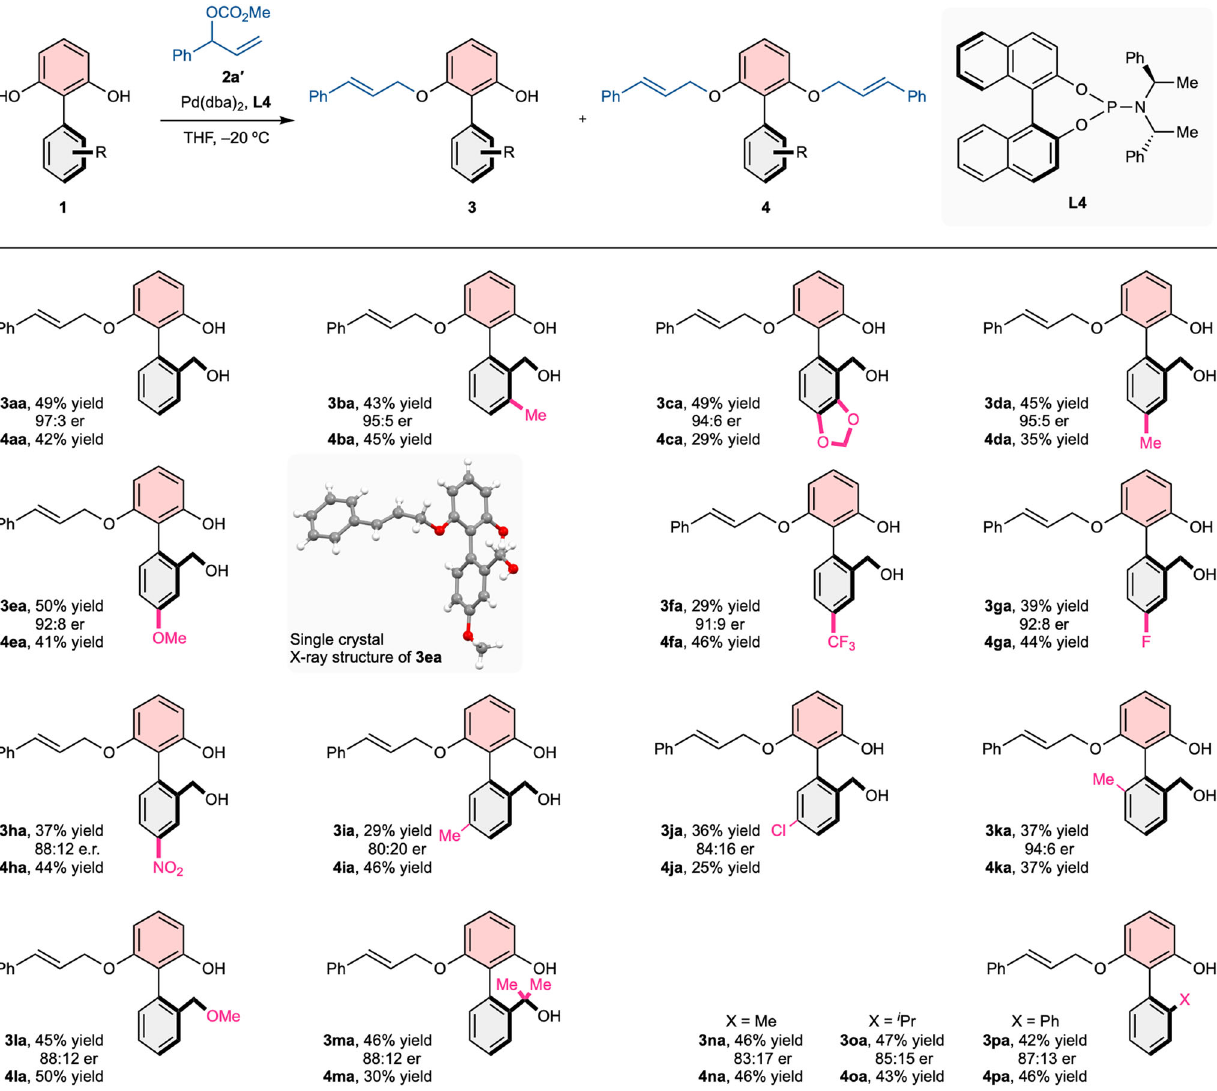
Fig. 2 Substrate scope of bottom aromatic ring. Unless otherwise noted, the reactions were carried out with 1 (0.10mmol, 1.0 equiv), 2a ′ (0.15 mmol, 1.5 equiv), Pd(dba) 2 (0.001 mmol, 0.01 equiv), L4 (0.004 mmol, 0.04 equiv), THF (0.5 mL, 0.2 M). Isolated yields. Enantiomeric ratios were determined by chiral-phase high-performance liquid chromatography